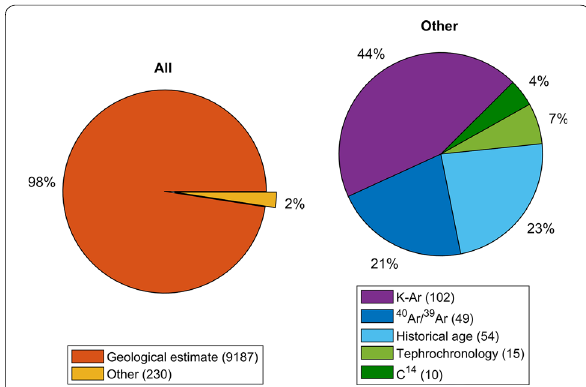
Fig. 8 Pie charts of dating methods. Distribution of ICEPMAG sites by dating method. NB: 74 sites (with no age or dating method specified) have been